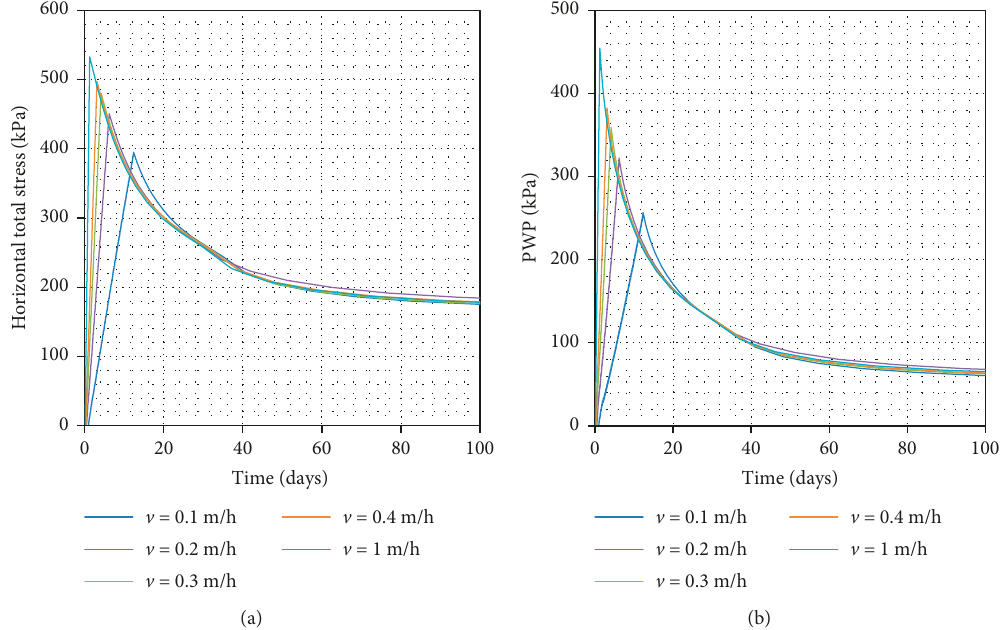
Figure 13: Evolution of the (a) horizontal total stress σ h and (b) PWP u w at midheight of the barricade for five different values of filling rate (see the details in Table 1, Case 3).